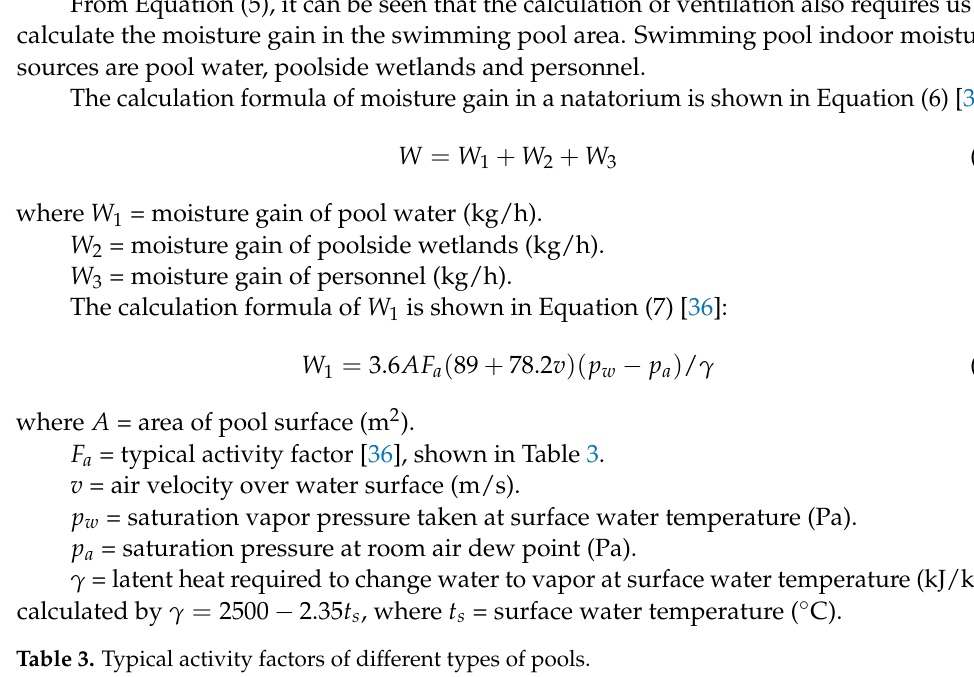
Table 3. Typical activity factors of different types of pools. Type of